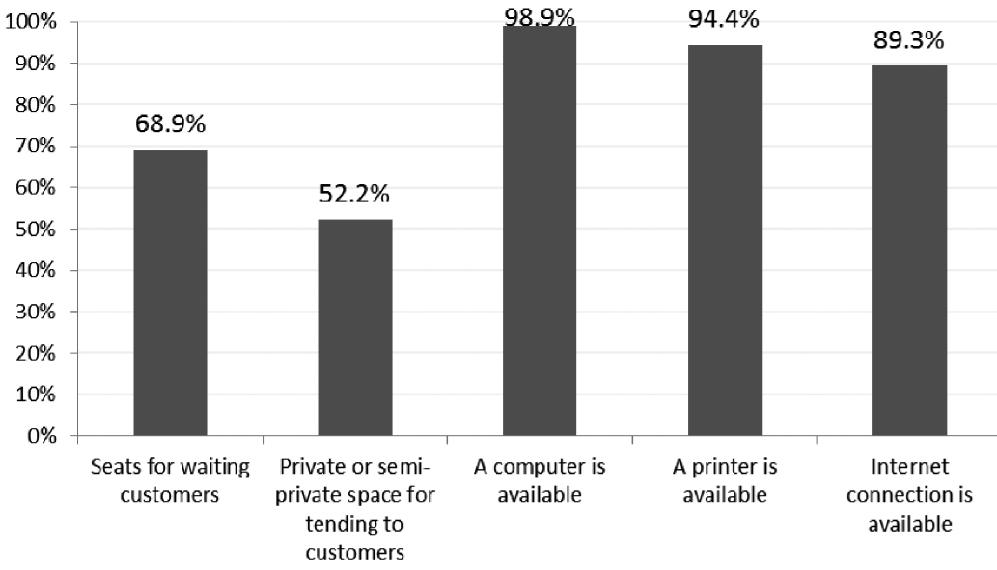
FIGURE 2 - Indicators of structure of community pharmacies in the State of Paraná.